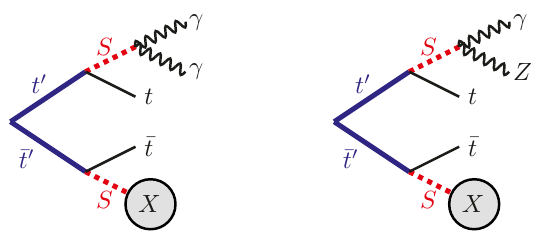
Figure 3 . Pair production of t 0 with decay of the t 0 into (anti-)top and S in both branches. S is then decayed in one branch into (cid:13) (cid:13) or Z (cid:13) , depending on the signal pursued, and inclusively in the other